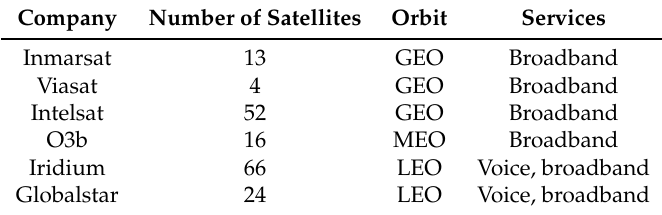
Table 1. A set of commercial constellations providing communication services as of